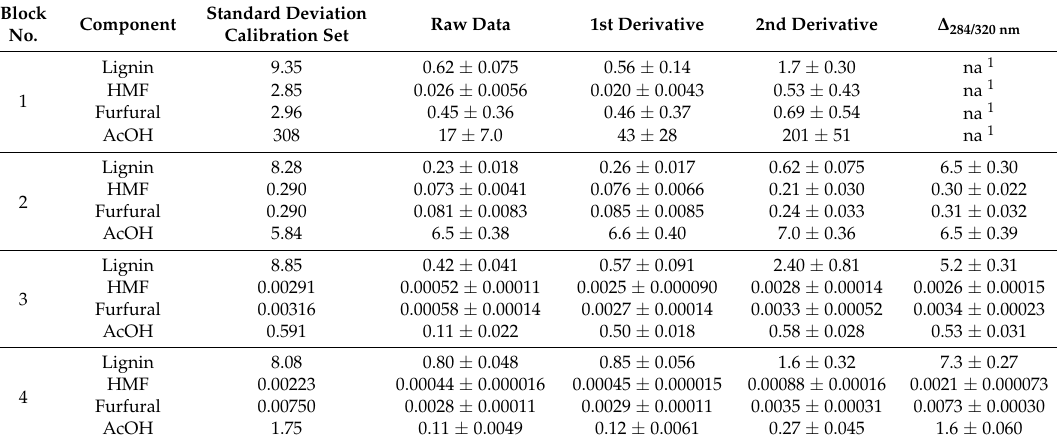
Table 1. Standard error of calibration of data blocks 1 to